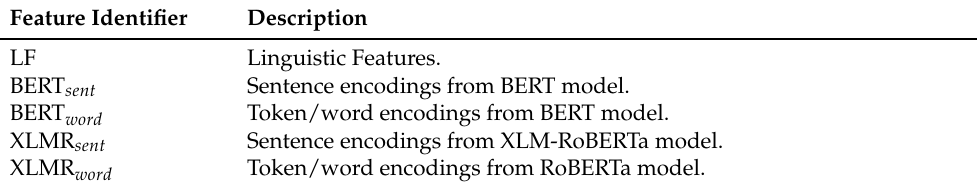
Table 3. Description of the explored feature sets.